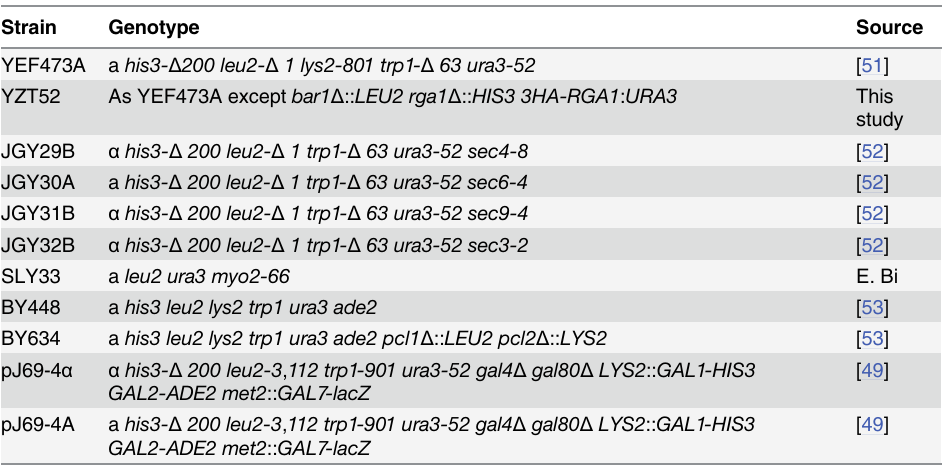
Table 1. Yeast strains used in this